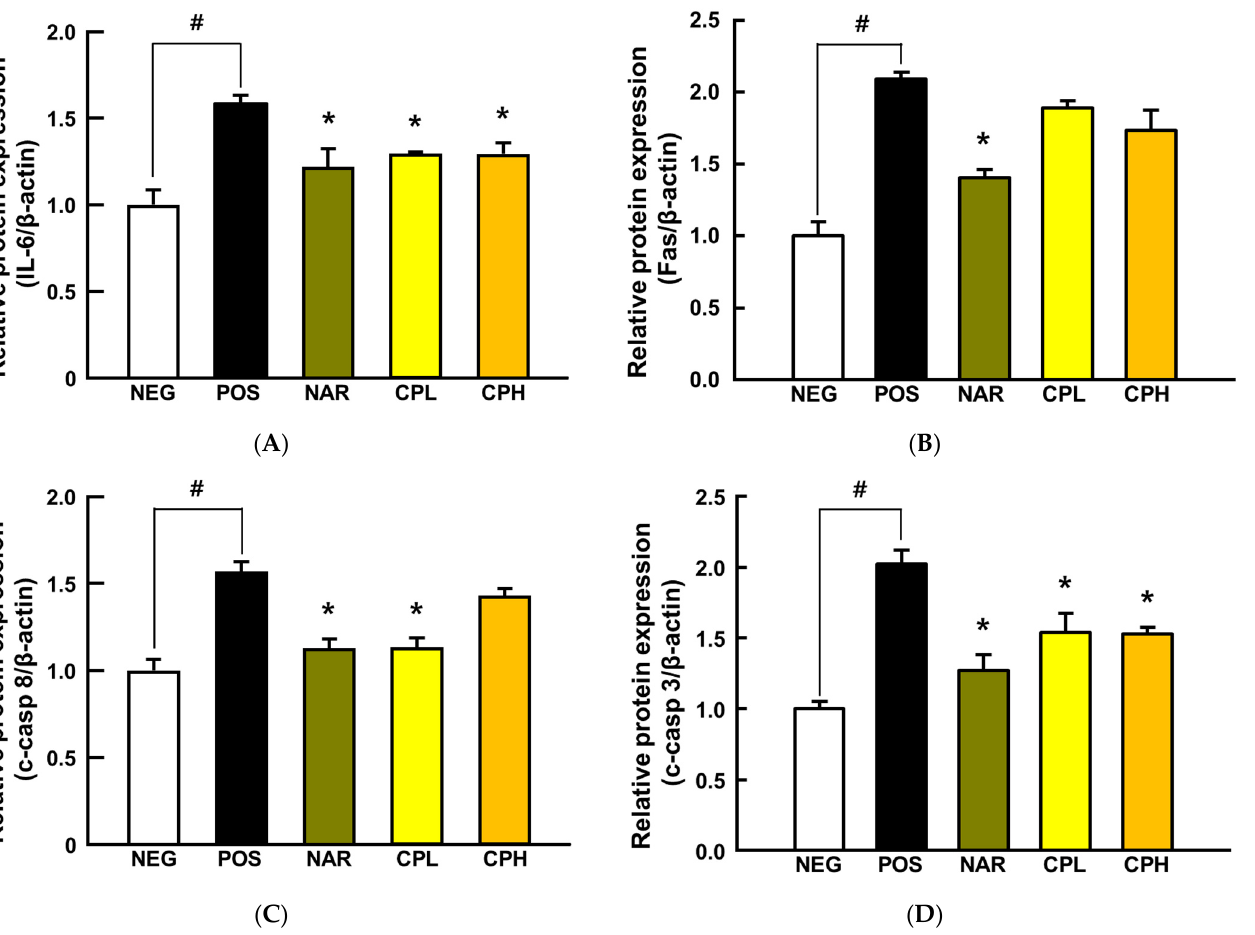
Figure 5. The expressions of pro-inflammatory cytokine- and apoptosis-related proteins in PM 10 - induced lung damage. ( A ) IL-6, ( B ) Fas, ( C ) c-caspase-8, and ( D ) c-caspase-3 expression. All values are expressed as mean ± SEM. p- value less than 0.05 was considered statistically significant. # indicates statistical significance compared to the NEG group, and * indicates statistical significance compared to the POS group. CPL, Citrus junos Tanaka peel extract low concentration; CPH, Citrus junos Tanaka peel extract high concentration; NAR, naringin; NEG, negative control; POS, positive control.